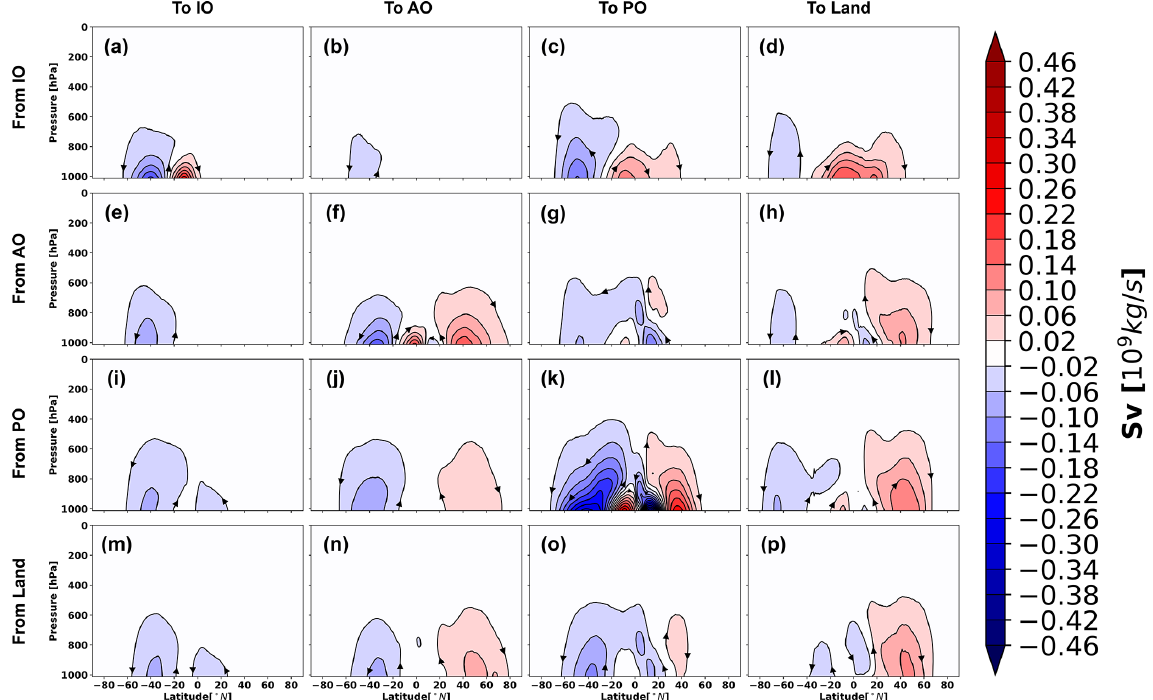
Figure 3. The Lagrangian meridional overturning stream function within and between the ocean basins and land. This has been undertaken by grouping the trajectories according to their starting and ending locations. The starting and ending points of the atmospheric trajectories are defined as per the sectors presented in Fig. 1. Note that the stream lines represent the integrated atmospheric water transport routes and is based on the sum of the Lagrangian trajectories, which should not be confused with the paths of the individual